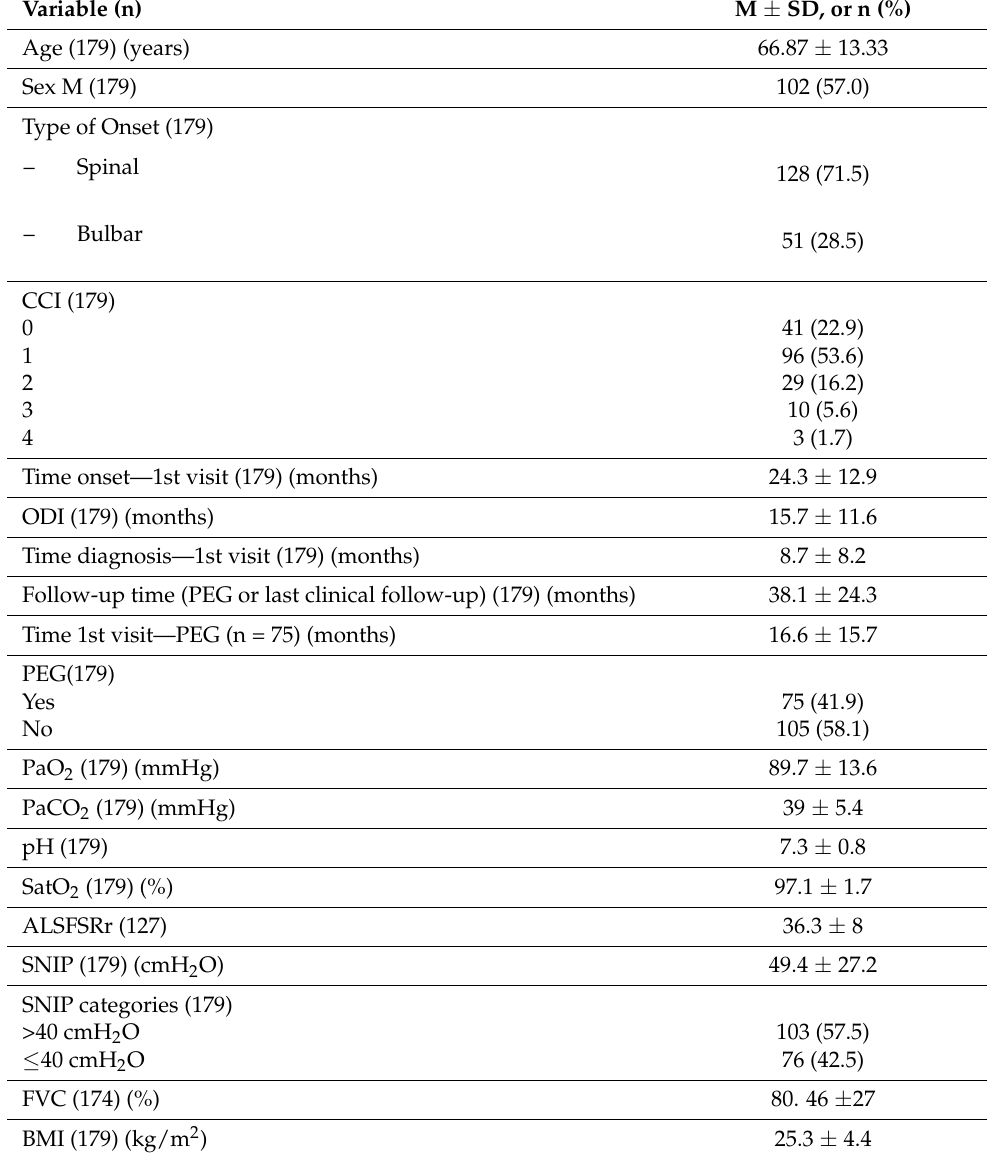
Table 1. Demographic and clinical characteristics of the whole sample (n =